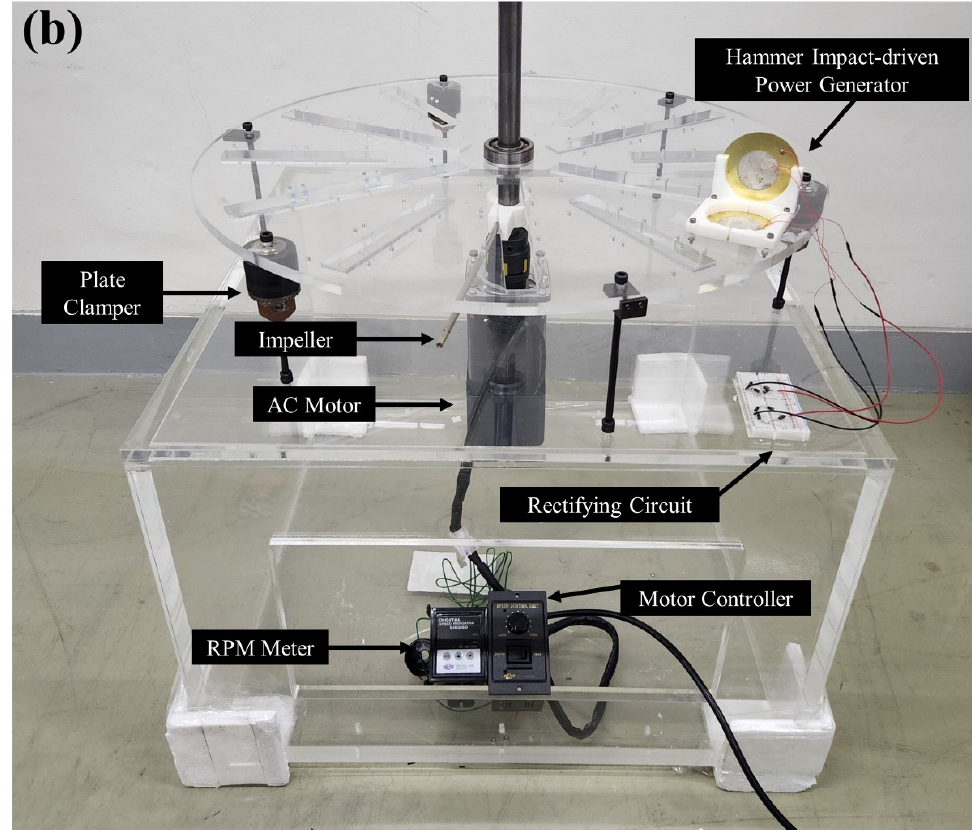
Figure 4. ( a ) Schematic and ( b ) photo image of handmade evaluation system to demonstrate power- generation performance of hammer-impact-driven power generator as a function of the rotation speed of the impeller.